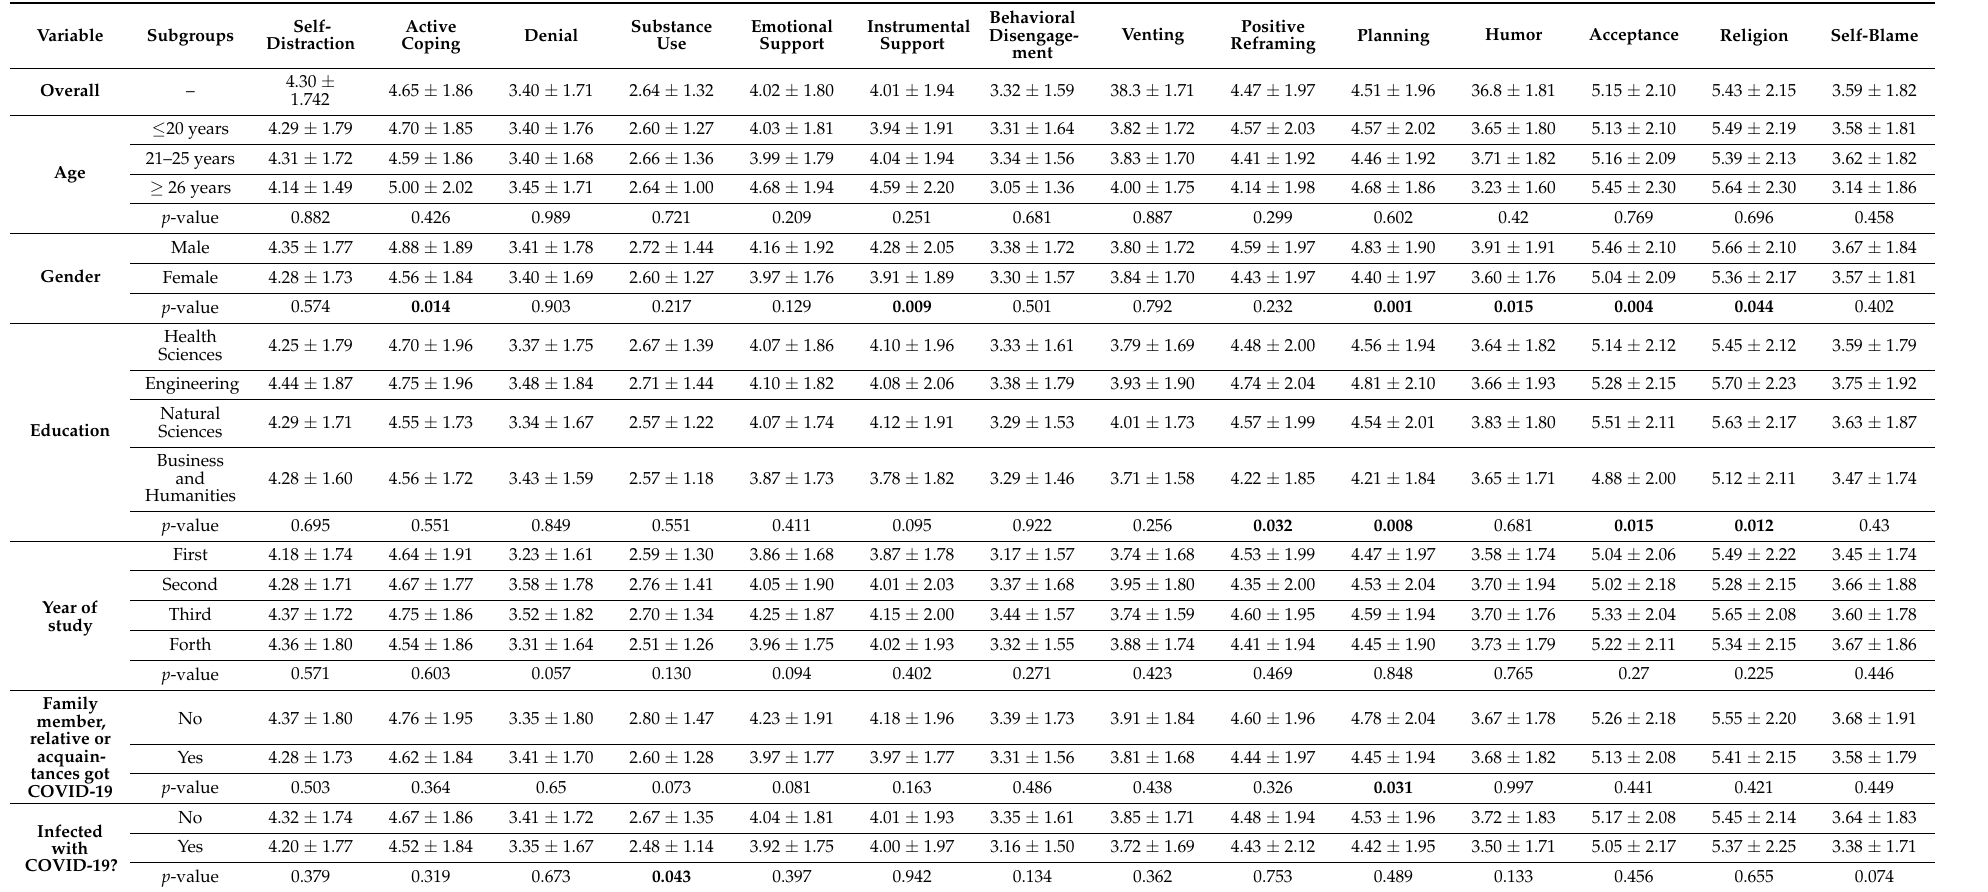
Table 2. Coping strategies adopted by the study